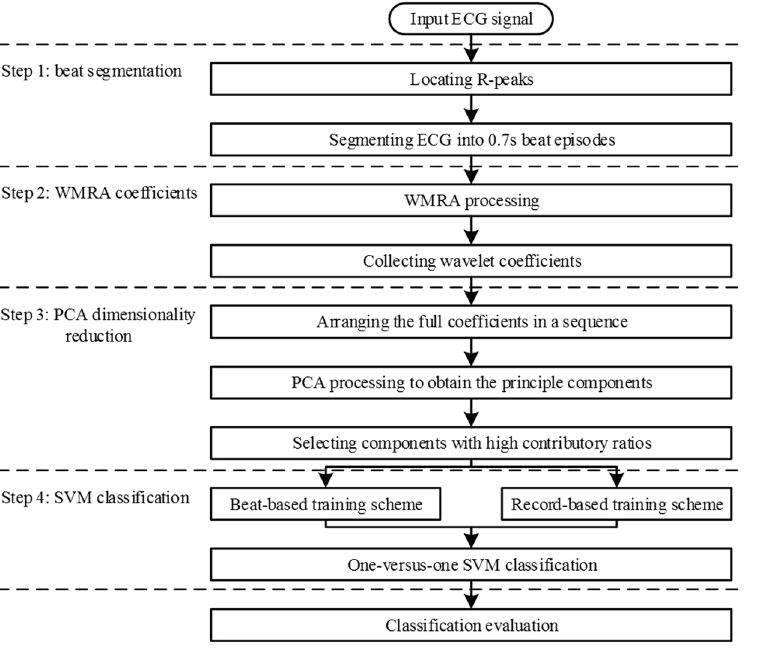
Figure 1. Block diagram of the proposed feature extraction algorithm.